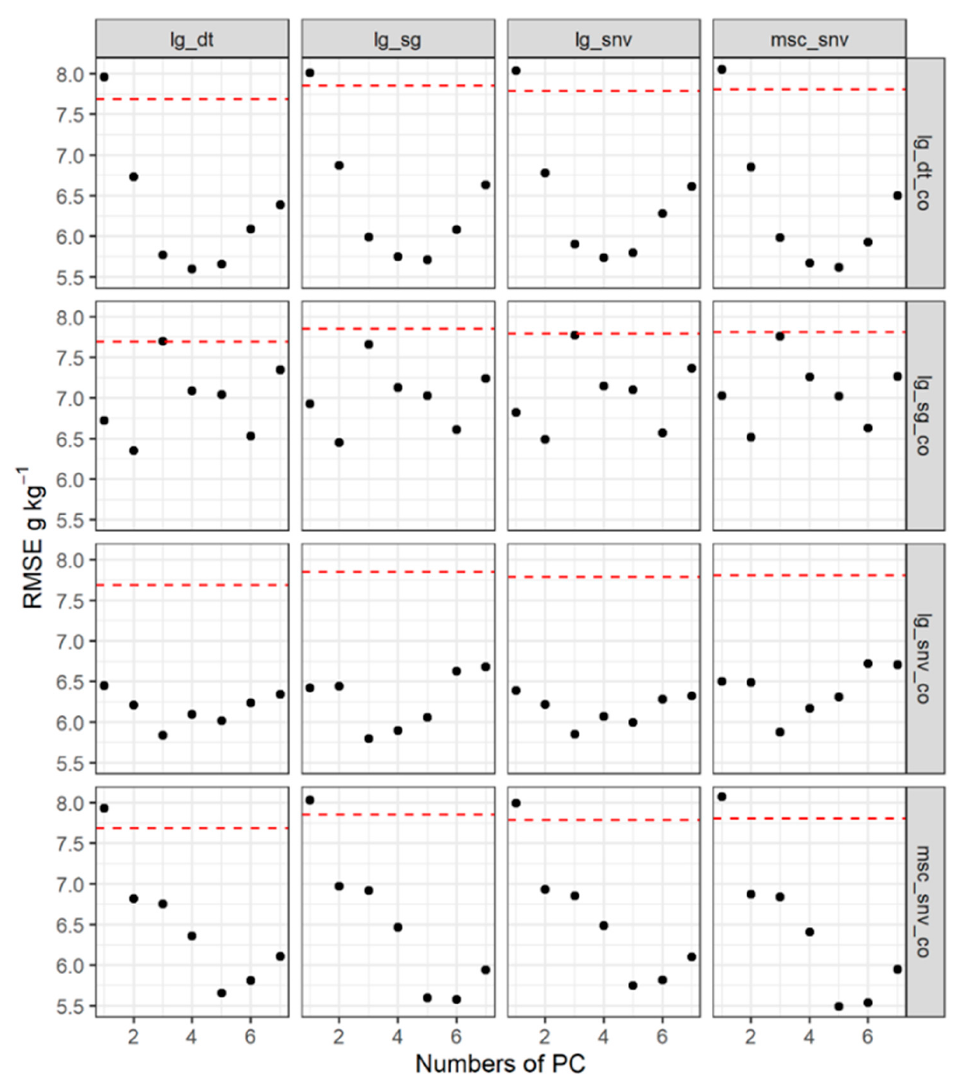
Figure 5. The RMSE calculated by the spatial model with four augmented data and 7 PCs as covari- ates induced from the spectra under four preprocessing methods. Each column represents that the augmented data were the same, but PCs (as the covariate) were induced from the different prepro- cessing methods. Each row representing PCs (as the covariate) was the same, but the augmented data were induced from the different preprocessing methods. The red lines show the RMSE value without the spectra as the covariate in the corresponding column, and each column had the same RMSE.